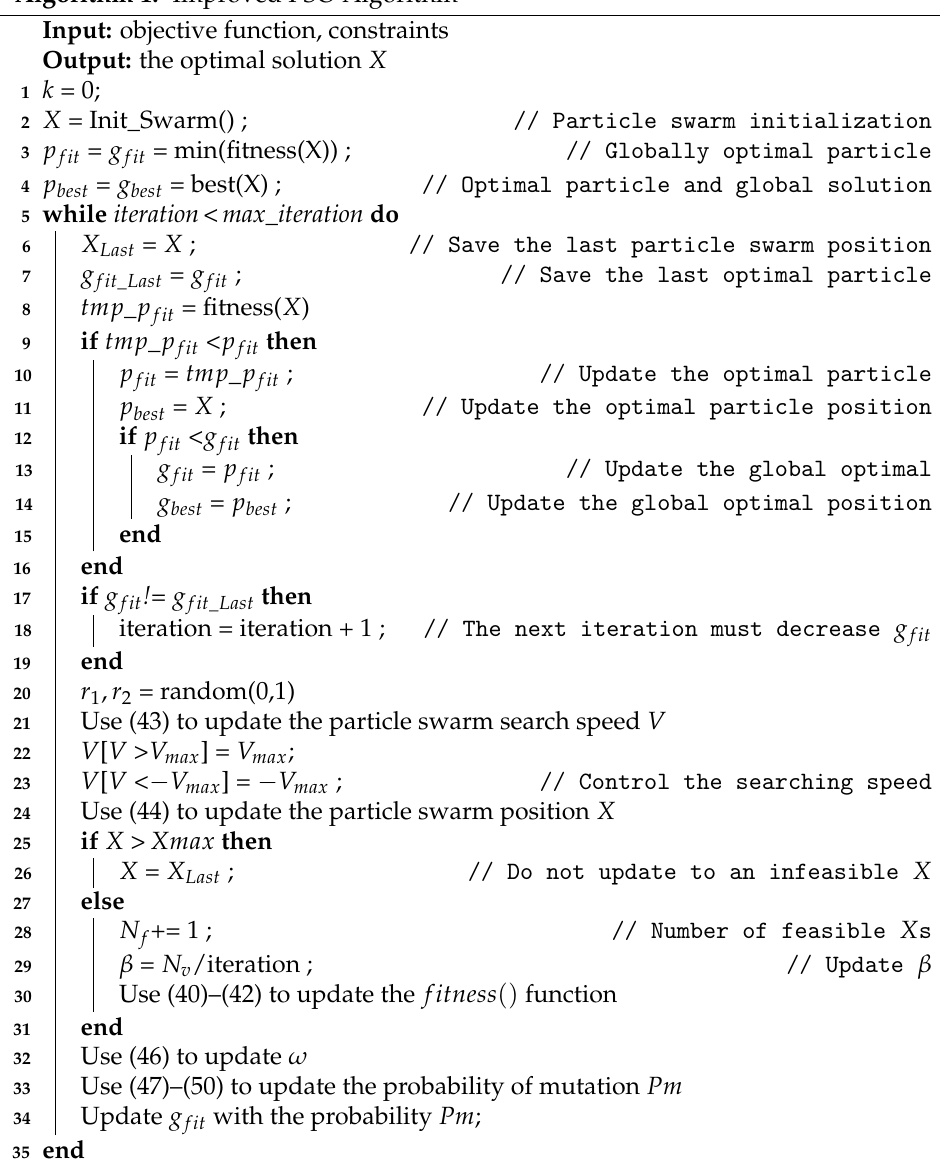
Algorithm 1: Improved PSO